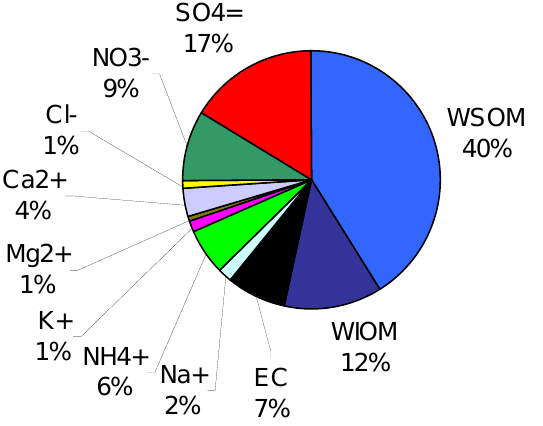
Fig. 4. Average PM 10 chemical composition with respect to car- bonaceous species and major ionic components. Data were derived by the average concentrations of both daytime and afternoon sam- ples in the various seasons weighted for the duration of the sam- plings and for the average duration of the seasons. Total recon- structed mass amounts to 3.48µg/m 3 (6.2µg/scm). WSOM stands for water-soluble organic matter (=WSOC × 2), while WIOM is the water-insoluble organic matter ((OC-WSOC) × 1.2).